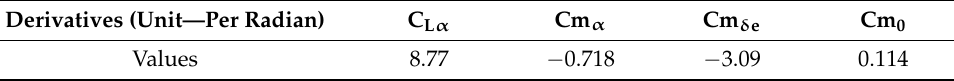
Table 19. Longitudinal stability derivatives.